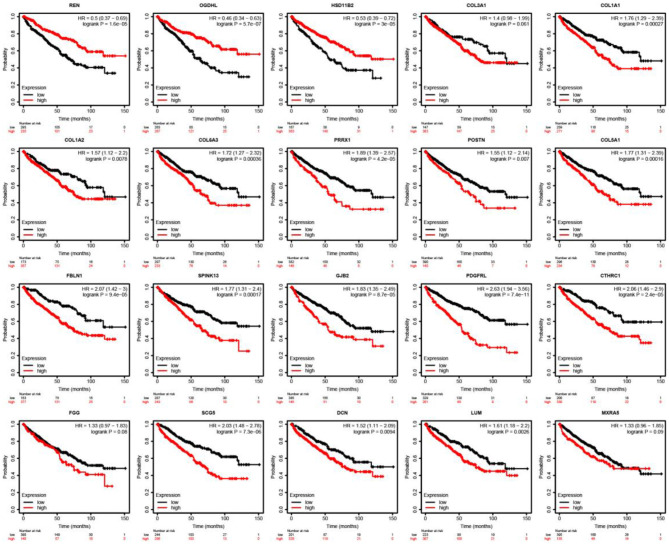
Outcomes associated with mutation and immune infiltrates were illustrated in patients with ccRCC. Kaplan-Meier survival curves with the log-rank test and hazard ratio (HR) for overall survival are shown.